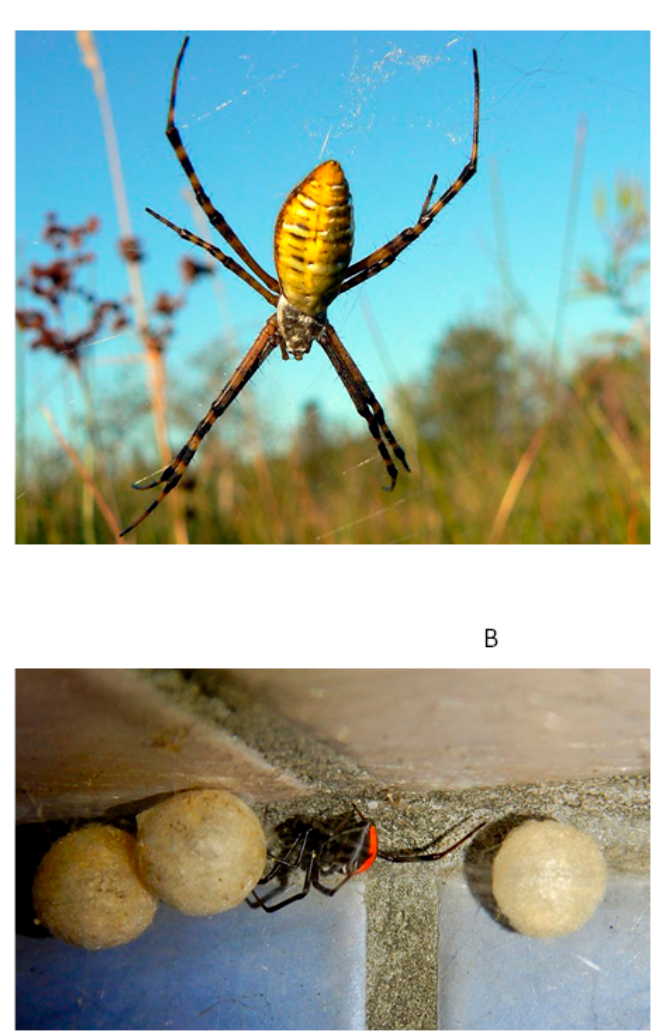
Figure 2. Photographs showing ( A ) Adult female of the banded argiope, Argiope trafasciata (Aranei- dae), sitting in its web and exposed in sunlight. This species is common is warm, dry climates and has body coloration (silver cephalothorax, yellow abdomen), which may help to re fl ect light and reduce heat absorption during the day. ( B ) Adult female of the Redback false widow spider, Latrodectus hasselti (Theridiidae), a tt ending three egg sacs. This species is found warm dry climates in its native Australia but avoids bright habitats and most commonly spins small, tangled webs un- der rocks, fallen trees and in other dark habitats (including around human habitation). Its primarily black coloration makes it poorly adapted to open habitats and direct exposure to sunlight.